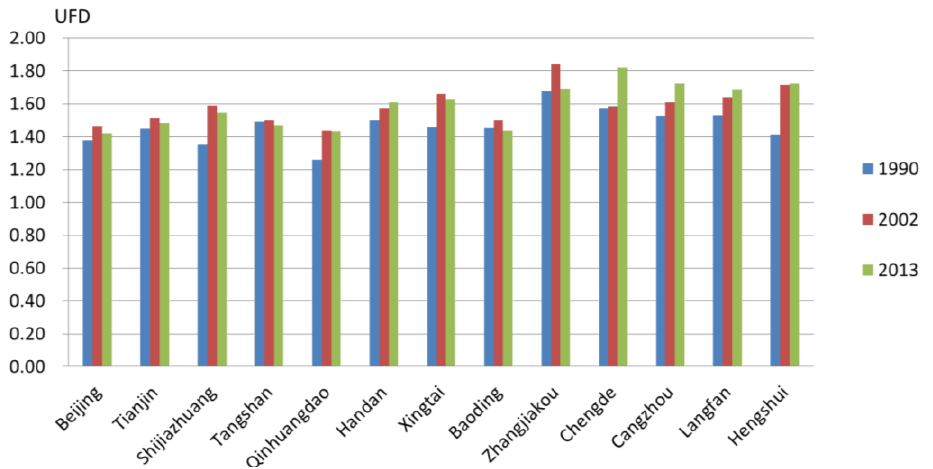
Figure 7. Changes of Urban Fractal Dimension (UFD) from 1990 to 2003 in BTH. Table 2. Urban Sprawl Coordination Coefficient (UECC) from 1990 to 2013 in BTH.